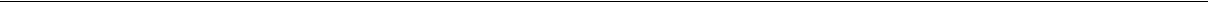
(Fig. 5a): the anti-Mip and dsx -positive vAL , ventral anterior medial ( vAM ), small ventral posterior medial ( s-vPM ), large ventral posterior medial ( l-vPM ), and small medial posterior medial ( s-mPM ). Apart from vAL , no other AG cells express anti- Mip. In males, we found no labelled neurons in the AG regions where vAL and vAM neurons are in females (Fig. 5a, b).